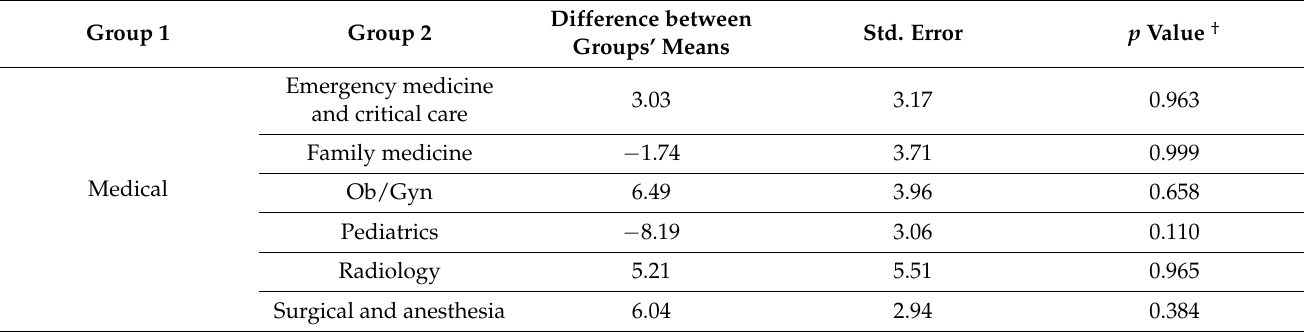
Table A2. Post hoc analysis of the differences in mean JSE scores between residents’ current